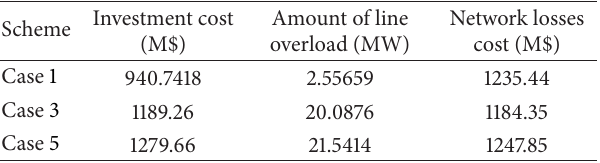
Table 2: Final plan of Cases 1, 3, and